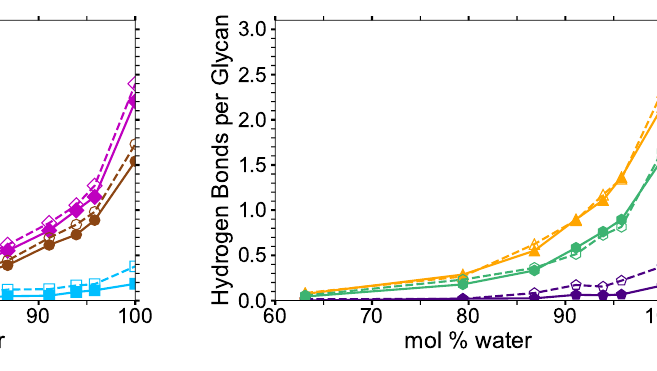
( c ) TBP-strand : first (dark pink) and second layer strands (brown and light blue).